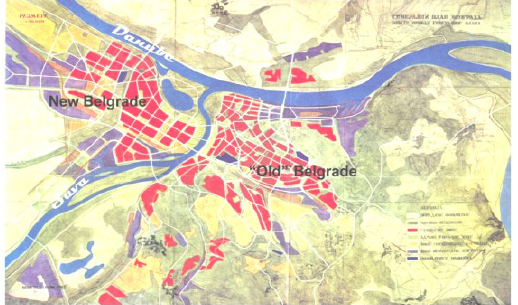
Figure 1. Belgrade: the city at the confluence of the rivers Danube and Sava (According to Master Plan of Belgrade of 1950)